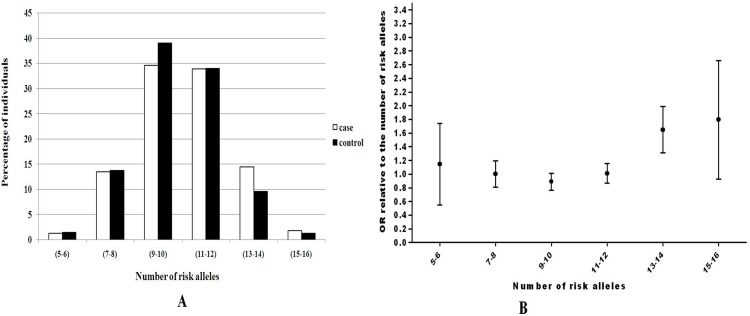
(a) Distribution of risk alleles in type 2 diabetic (white bars) and control subjects (black bars) (b) Depiction showing the trend in ORs with the increasing number of type 2 diabetes risk alleles versus the baseline of 5–6 risk alleles.The vertical bars represent 95% CIs.